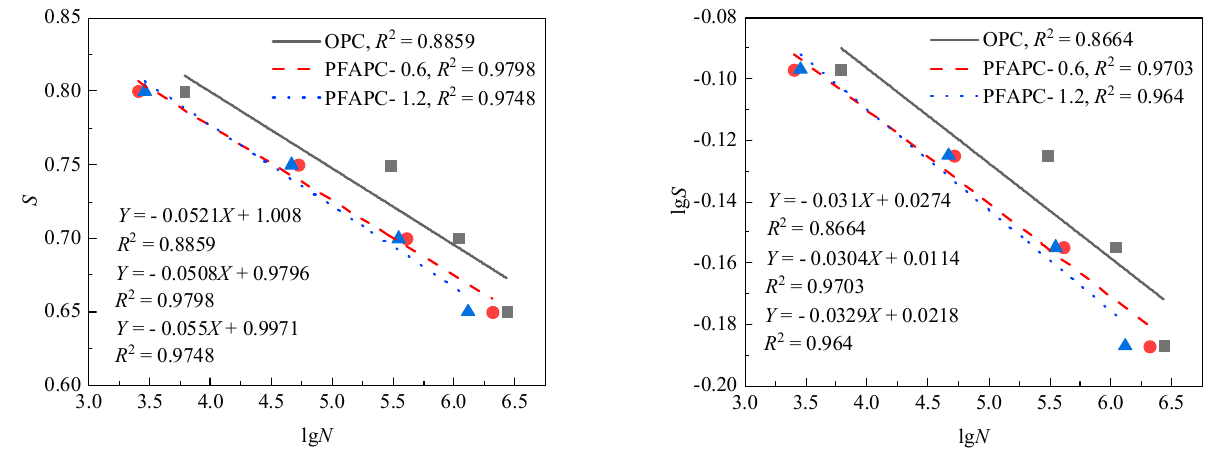
Figure 8. P-S-N curve when survival probability P = 50% is considered under two-parameter Weibull distribution.